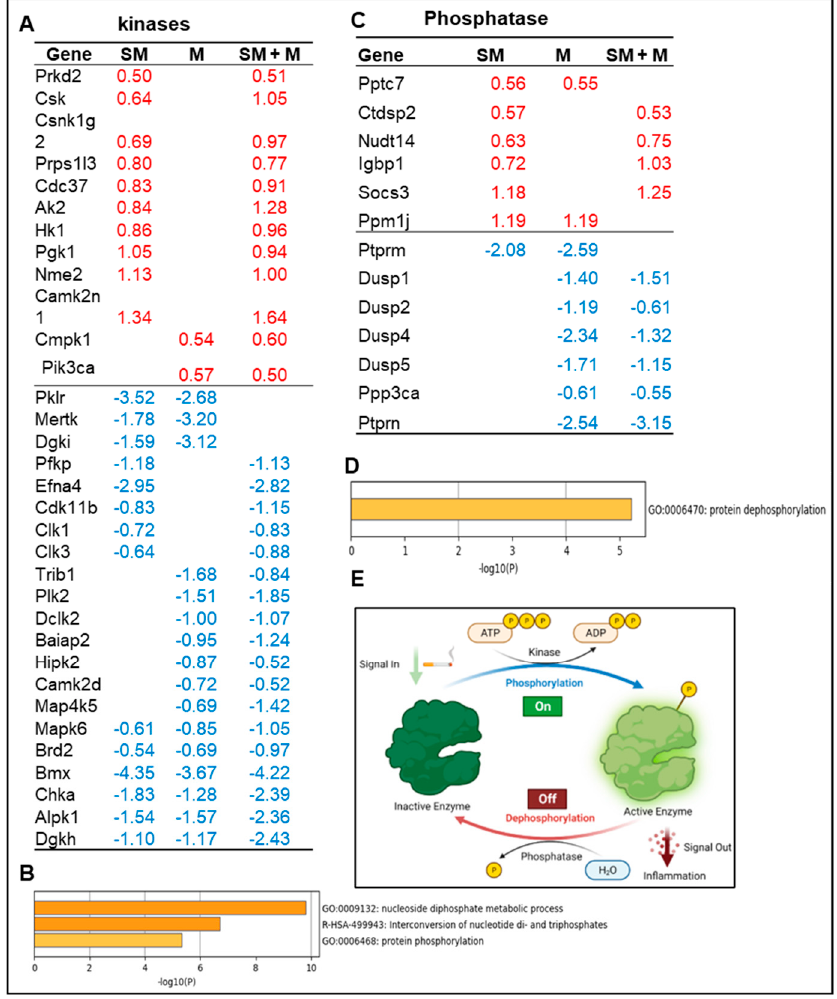
Figure 3. ( A ) The gene annotation from ingenuity pathway analysis (IPA) showed that cigarette smoke plus morphine, morphine, and cigarette smoke upregulated the expressions of 12, 2, and 10 kinases and downregulated 18, 16, and 14 kinases in splenic Tregs, respectively. ( B ) The metascape pathway analysis for the upregulated kinases. ( C ) The gene annotation from IPA showed that cigarette smoke plus morphine, morphine, and cigarette smoke upregulated the expressions of 4, 2, and 6 phosphatases and downregulated 6, 7, and 1 phosphatases in splenic Tregs, respectively. ( D ) The metascape pathway analysis for the upregulated kinases. ( E ) Schematic figure showed the kinases (phosphorylation) and phosphatases (dephosphorylation) of proteins and their effects on inflam- mation.